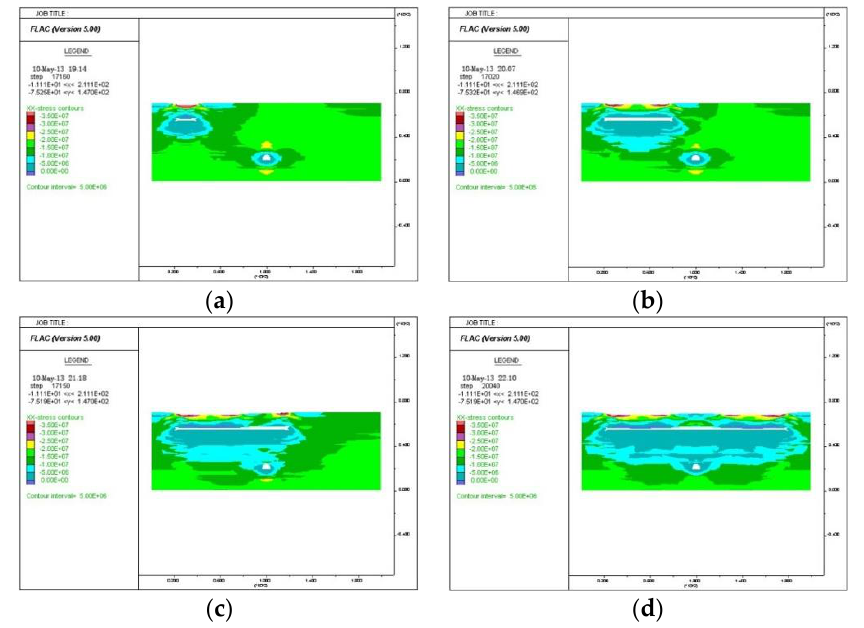
Figure 14. Horizontal stress distribution of surrounding rock of roadway supported by bolt and shed. ( a ) Working face is 60 m away from the roadway. ( b ) Working face is 20 m away from the roadway. ( c ) Working face spans the roadway 20 m. ( d ) Working face spans the roadway 60 m.